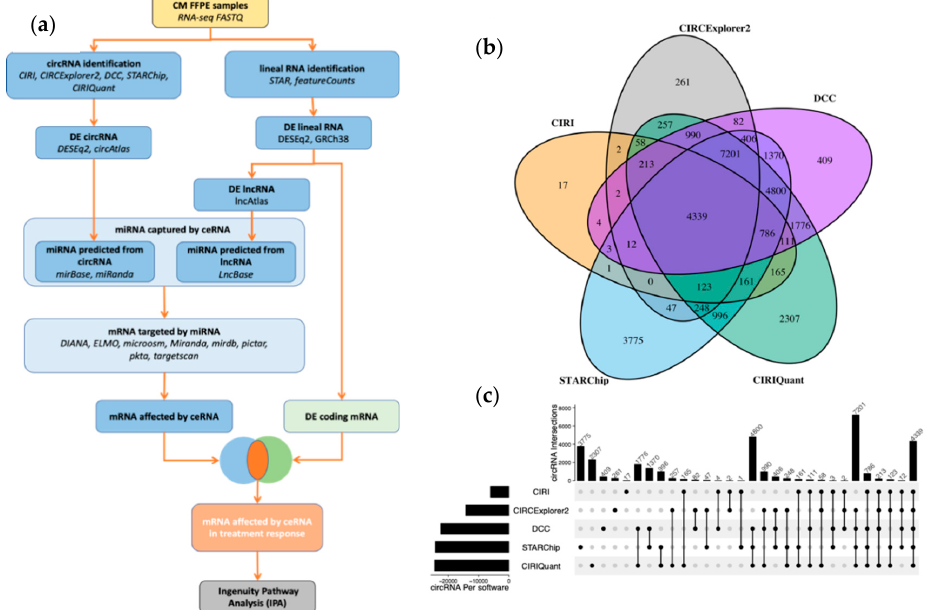
Figure 1. Workflow and circRNA tools comparison. ( a ) Bioinformatic workflow of the ceRNA interaction network. The pipeline is depicted from the RNA-seq fastq files to the Ingenuity Pathway analysis. Five different software packages were employed to identify circRNAs. mRNAs affected by ceRNAs were predicted by their interaction with miRNA. Differential expression analysis with DESeQ2 was used to decipher differences in responses to immunotherapy. ( b ) Venn diagram with the number of different cirRNAs detected by each software. ( c ) UpSet plot showing the maximum number of identified circRNAs with each software combination .